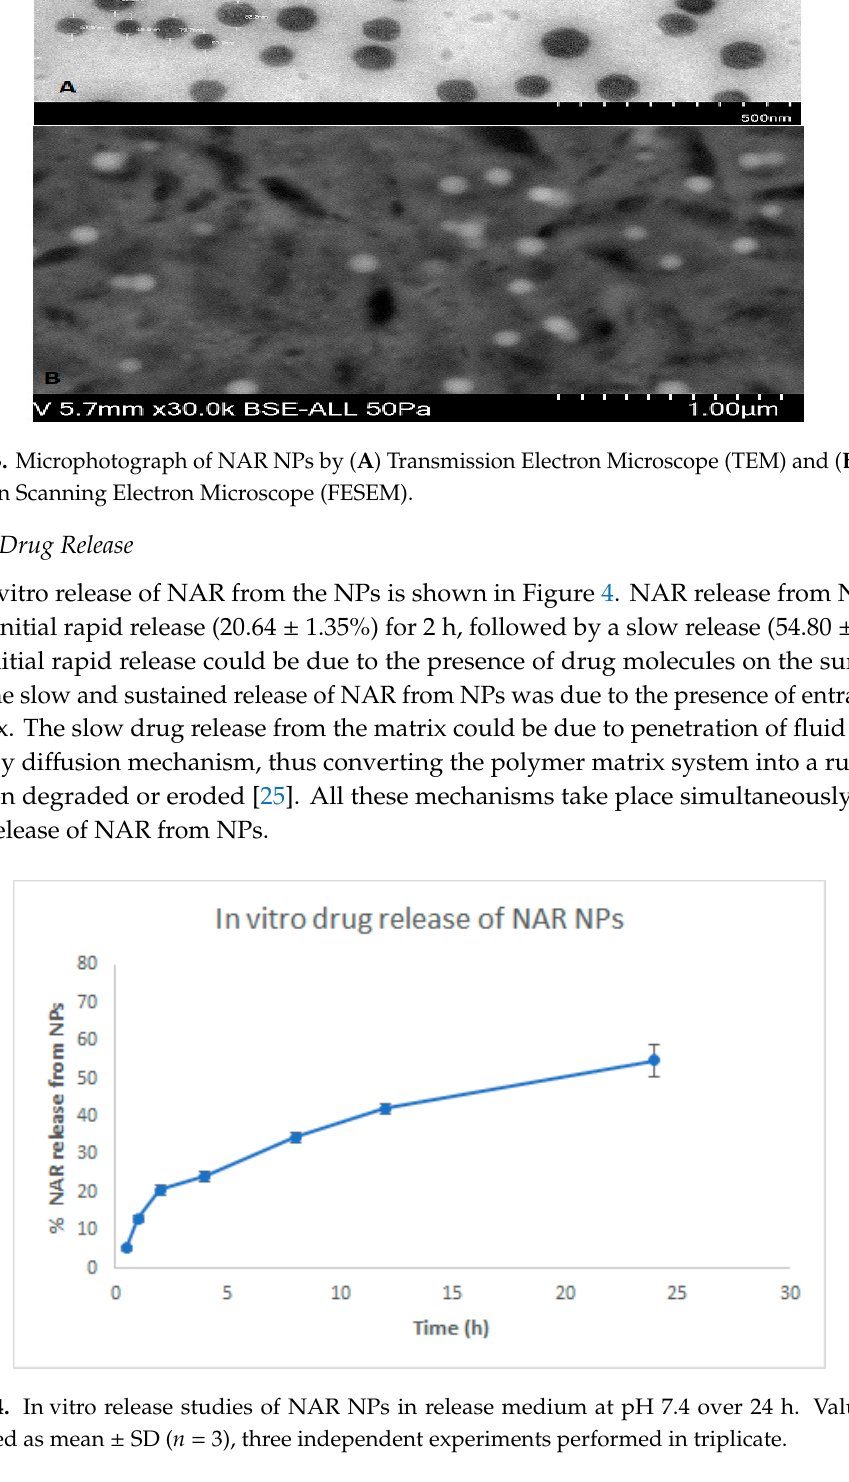
Figure 2. Represent zeta potential of blank NPs ( A ) and NAR NPs ( B ) measured by zetasizer.